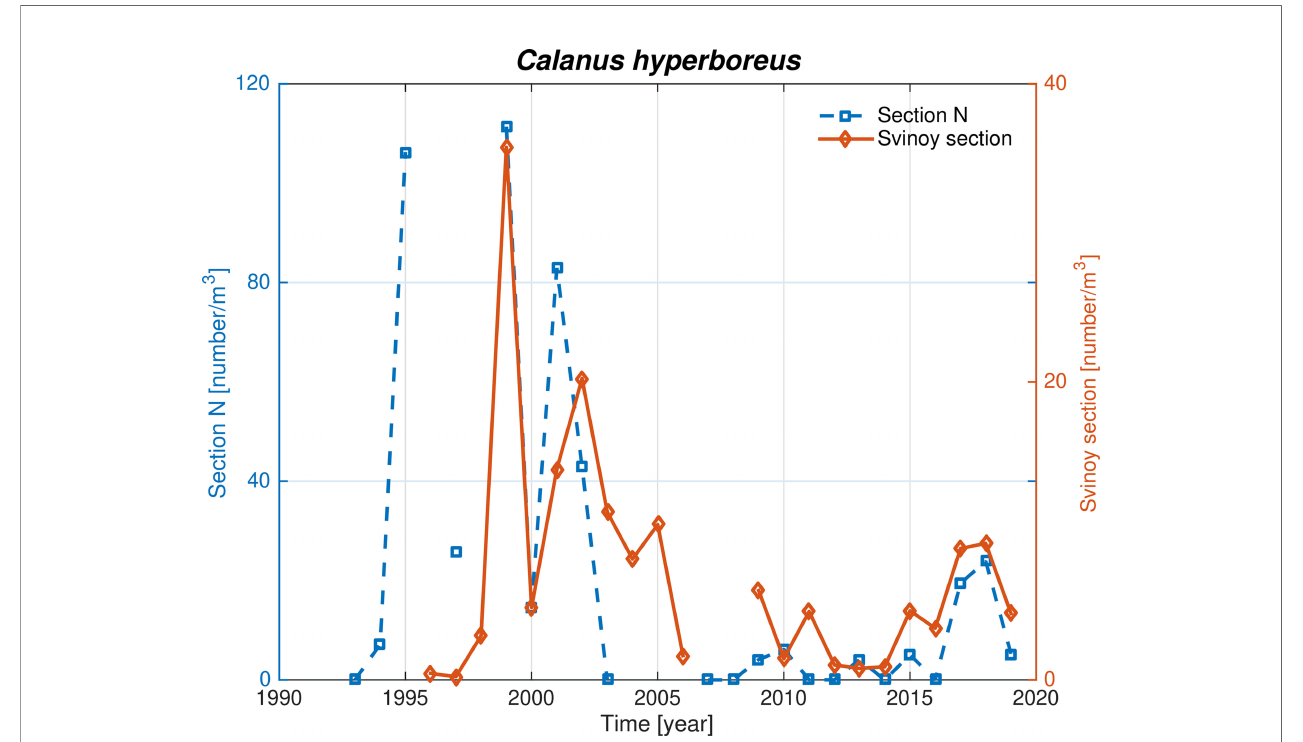
FIGURE 9 | Calanus hyperboreus at the Section N (blue) and Svinøy section (red) during